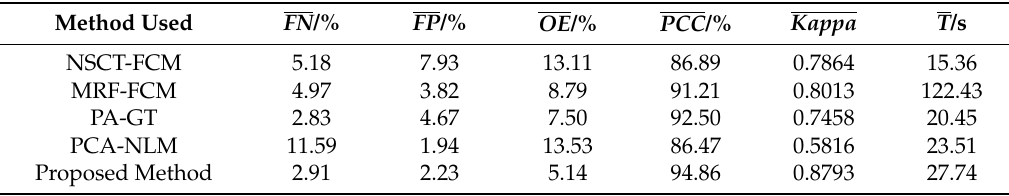
Table 4. Results of detecting the average change of multi-spectral remote sensing